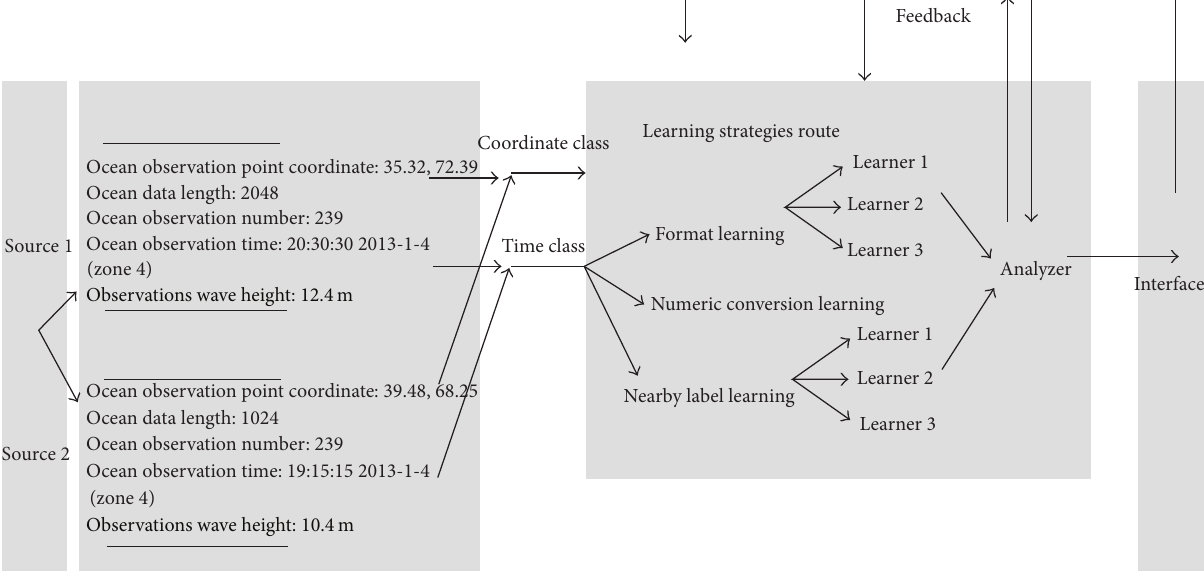
Figure 4: Machine schema mapping process of marine observation